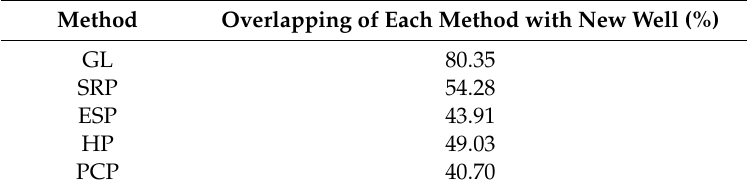
Figure 6. Model results ( a ) standards for all methods of exploitation, ( b ) overlapping of the gas lift (GL) standard with a new well, ( c ) overlapping of the electric submersible pumps (ESP) standard with a new well, ( d ) overlapping of the sucker rod pumps (SRP) standard with a new well, ( e ) overlapping of the hydraulic jet type pump (HP) standard with a new well, ( f ) overlapping of the progressive cavity pumps (PCP) standard with a new well. Table 5. Percentage of overlapping of 5 surfaces of oil exploitation method with new well.